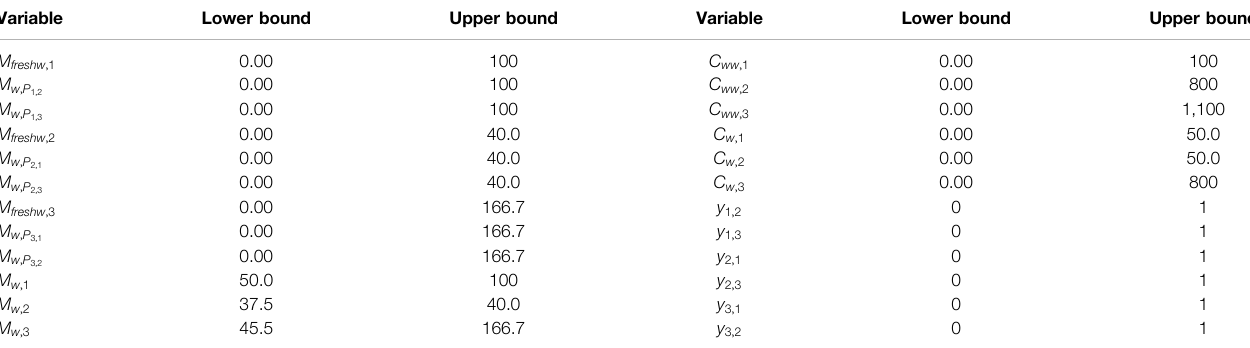
TABLE 8 | Characterization of decision variables of the MINLP model.